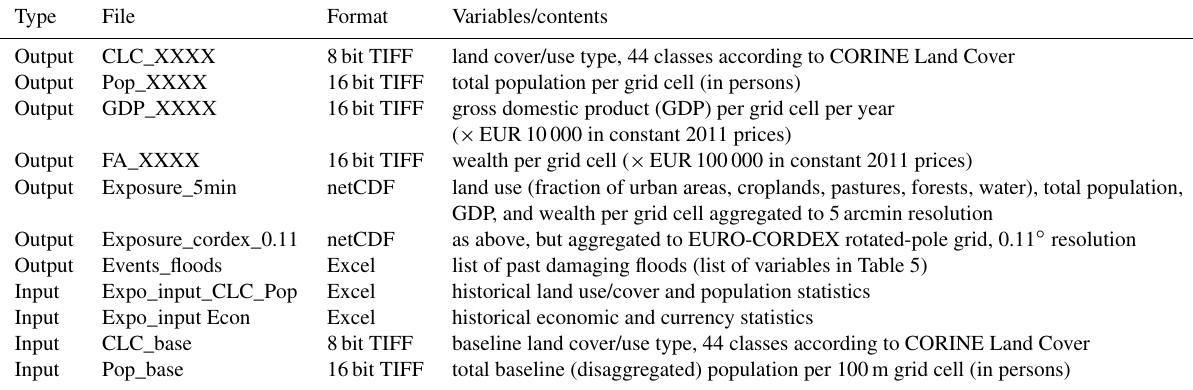
Table 4. List of files of HANZE database. XXXX represents the value indicating the year to which data set pertains.